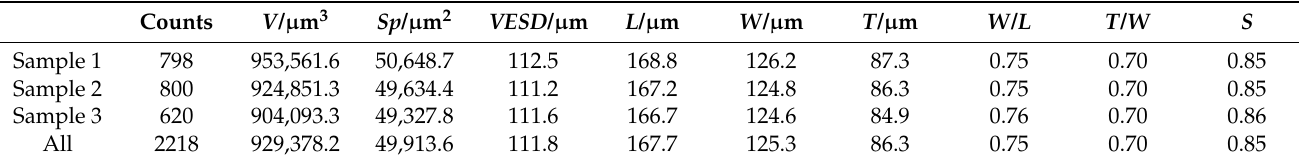
Table 1. Average values of the derived size and shape metrics of the desert sand particles from three CT scans.